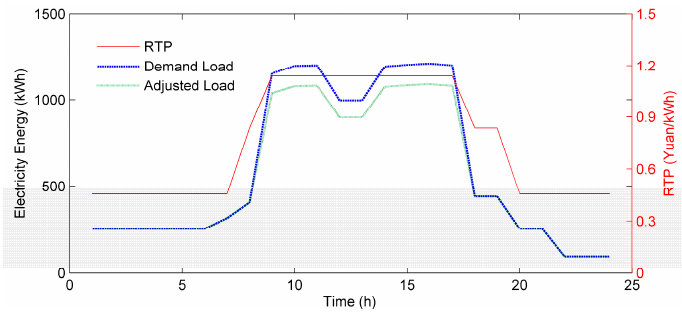
Figure 6. Strategies of Nash equilibrium (NE) in Scenario 1.